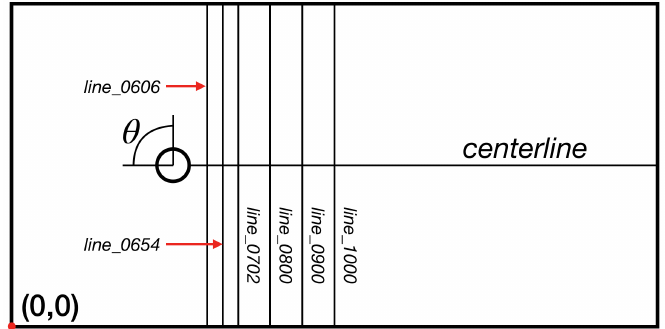
Figure 7. Sampling diagram. The name of the vertical line corresponds to its x coordinate, for example, line_0606 means x = 0.606.